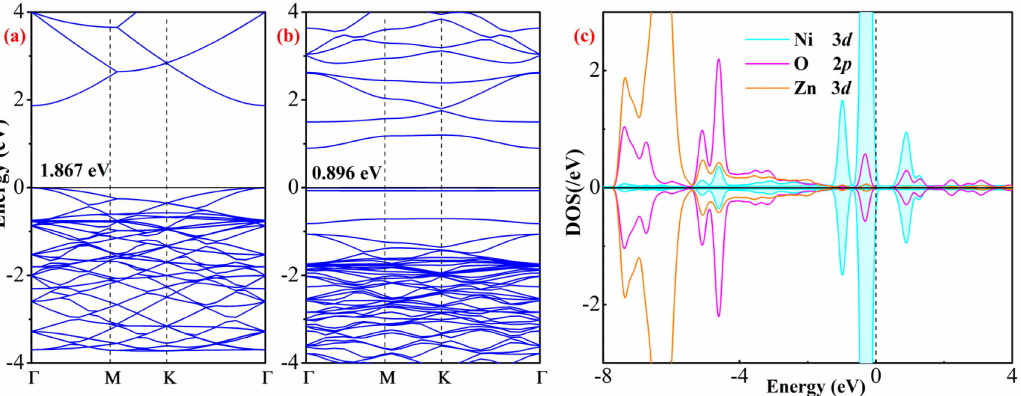
Figure 2. BS of ( a ) pristine ZnO monolayer ( b ) Ni–ZnO monolayer, and ( c ) atomic DOS of new- bonded atoms. In BS, the black value is the bandgap while in DOS the dash line is the Fermi